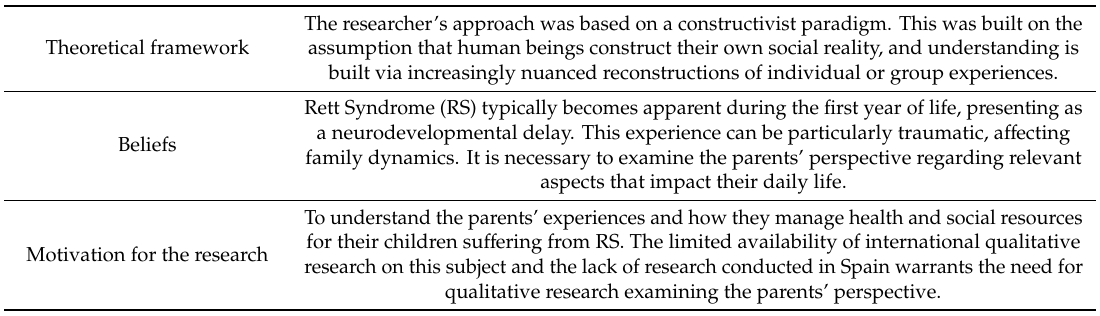
Table 1. The positioning of the